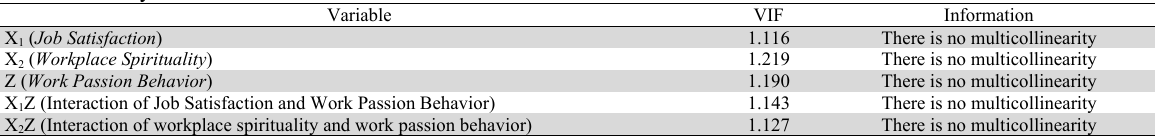
Multicollinearity test